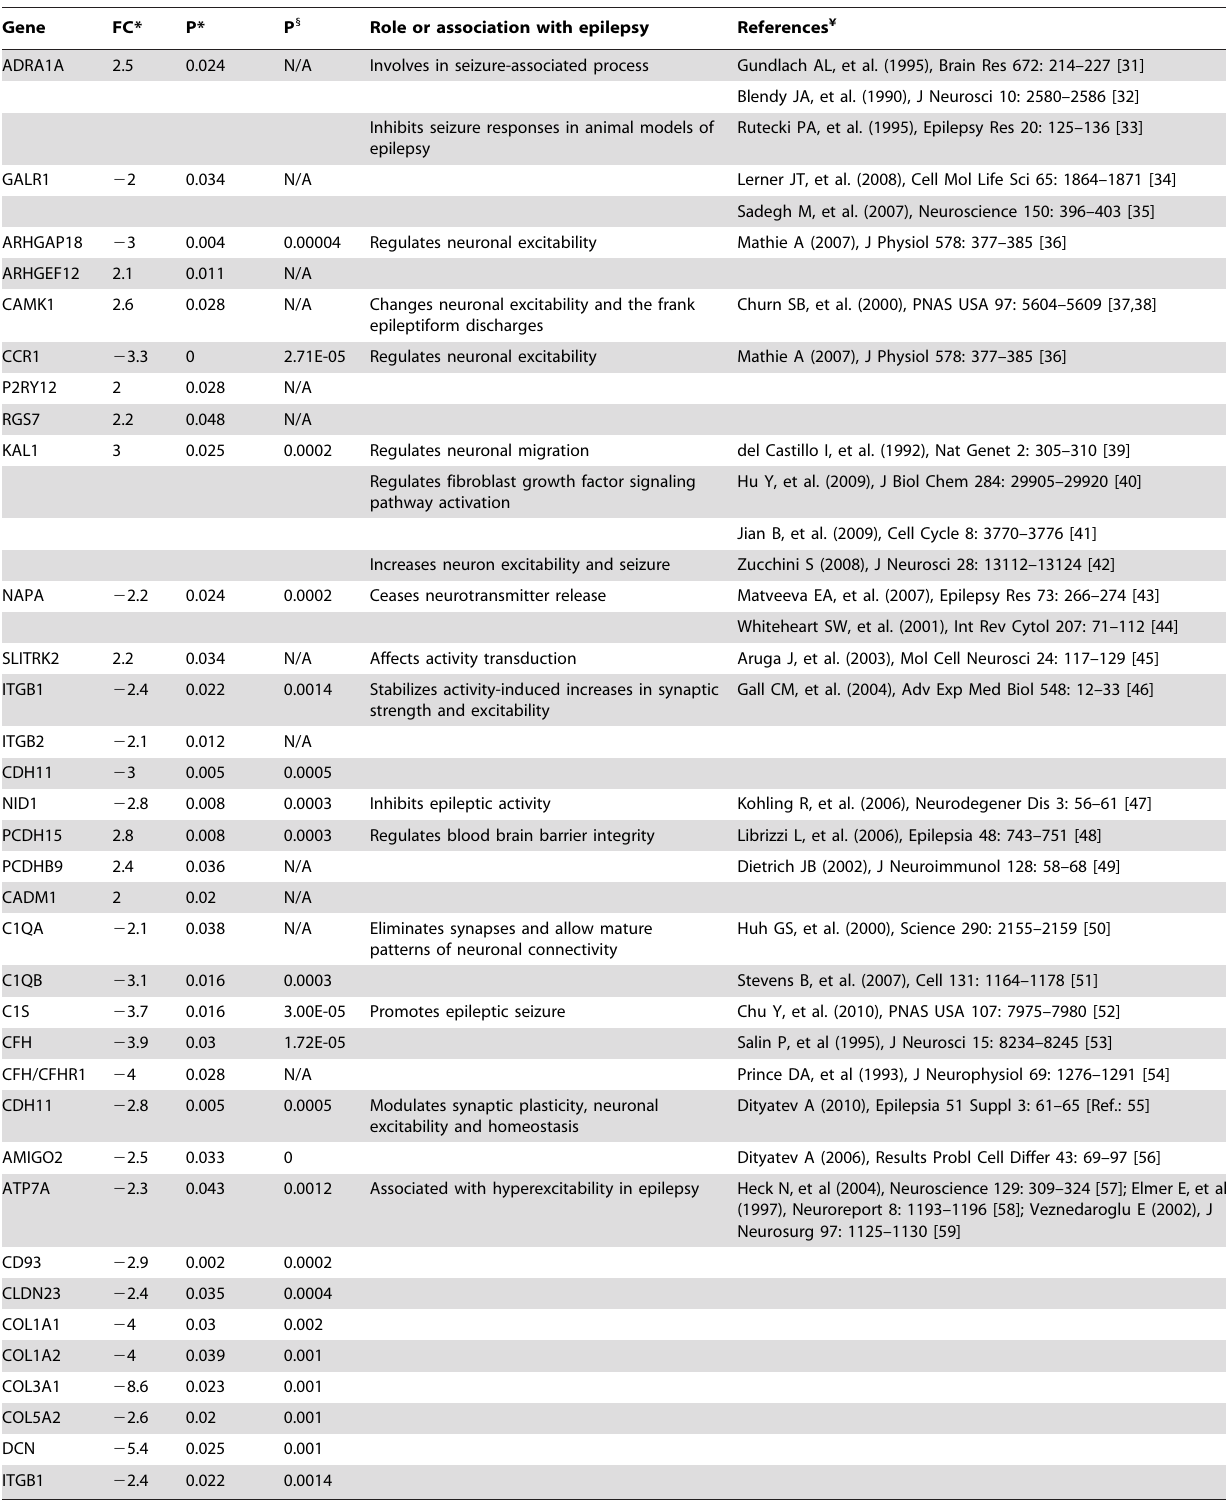
Table 2. Dysregulated genes associated with epilepsy documented in